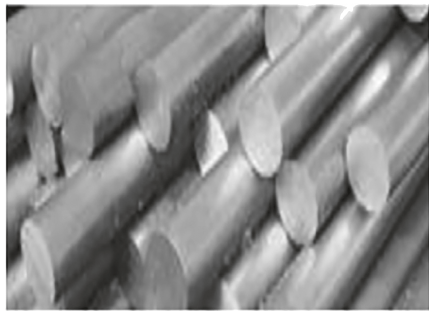
Figure 1: Metal matrix composite.